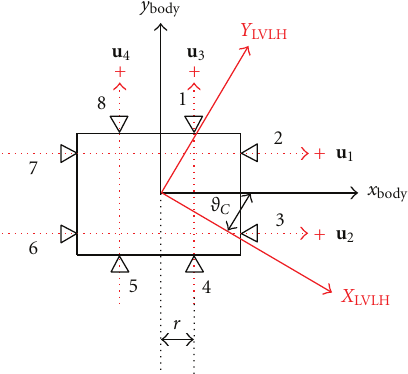
Figure 11: Thruster coupling on the spacecraft